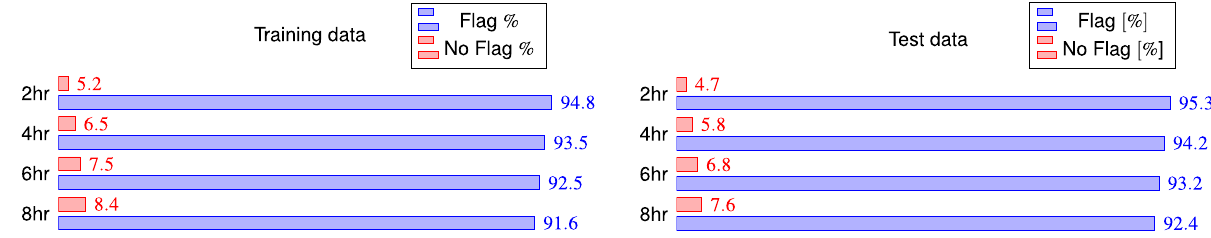
Figure 1. Class distribution per alerting horizon in train and test data